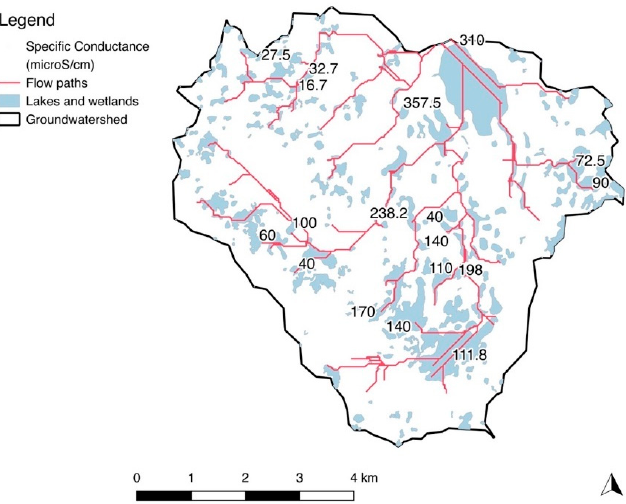
Figure 9. Groundwater flow path lines (in red) for the study area with mean specific conductance measurements shown for sampled lakes and wetlands.